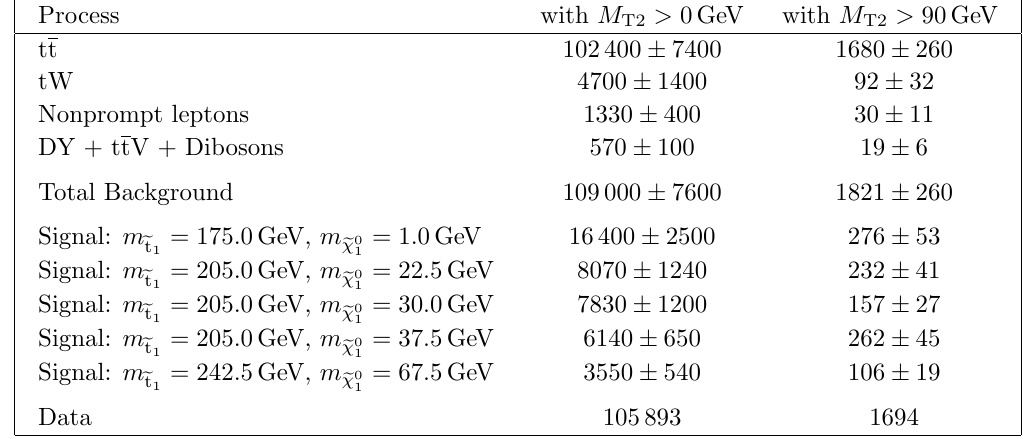
Figure 4 . M T2 distribution (pre(cid:12)t) for data and predicted background. The M T2 distribution for a signal corresponding to a top squark mass of 205 GeV and a neutralino mass of 30 GeV is also shown, stacked on top of the background estimate. The hatched bands correspond to the combined systematic and statistical uncertainties on background rates. The last bin of the histogram includes the over(cid:13)ow events. The lower pane shows the ratio between the observed data and the predicted SM